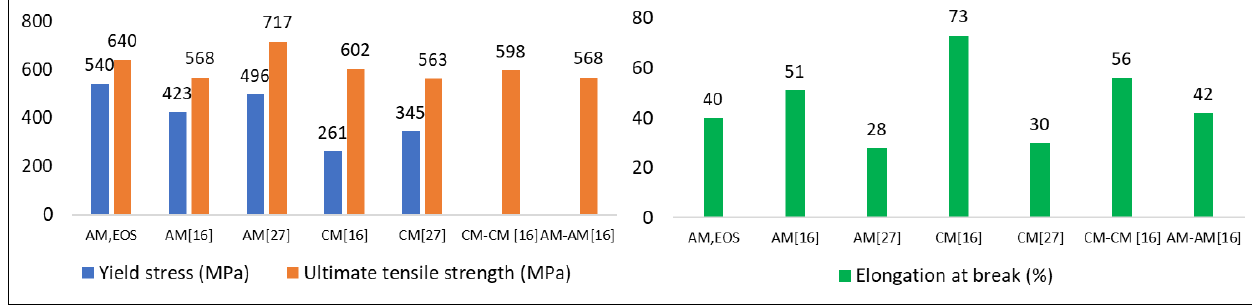
Figure 15. Tensile test results in a similar study and supplier values for L-PBF material.